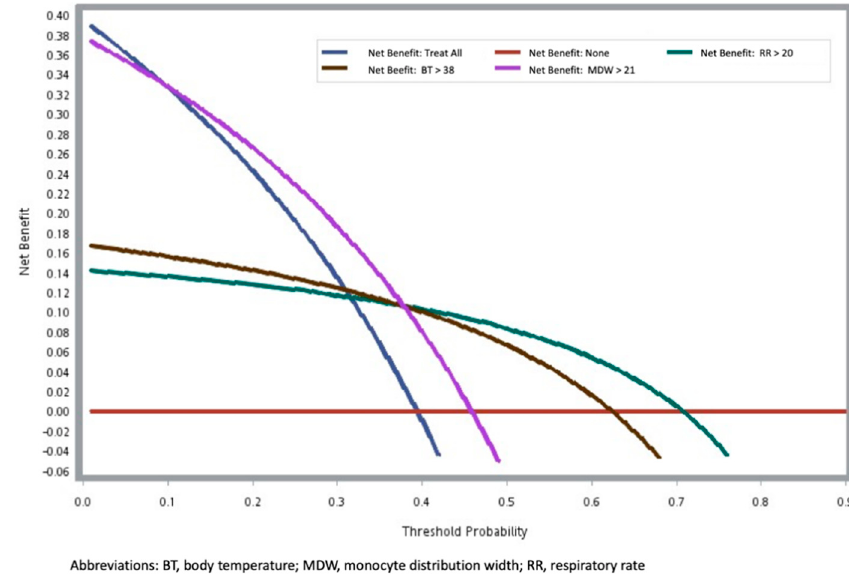
Figure 2. The decision curve analysis.